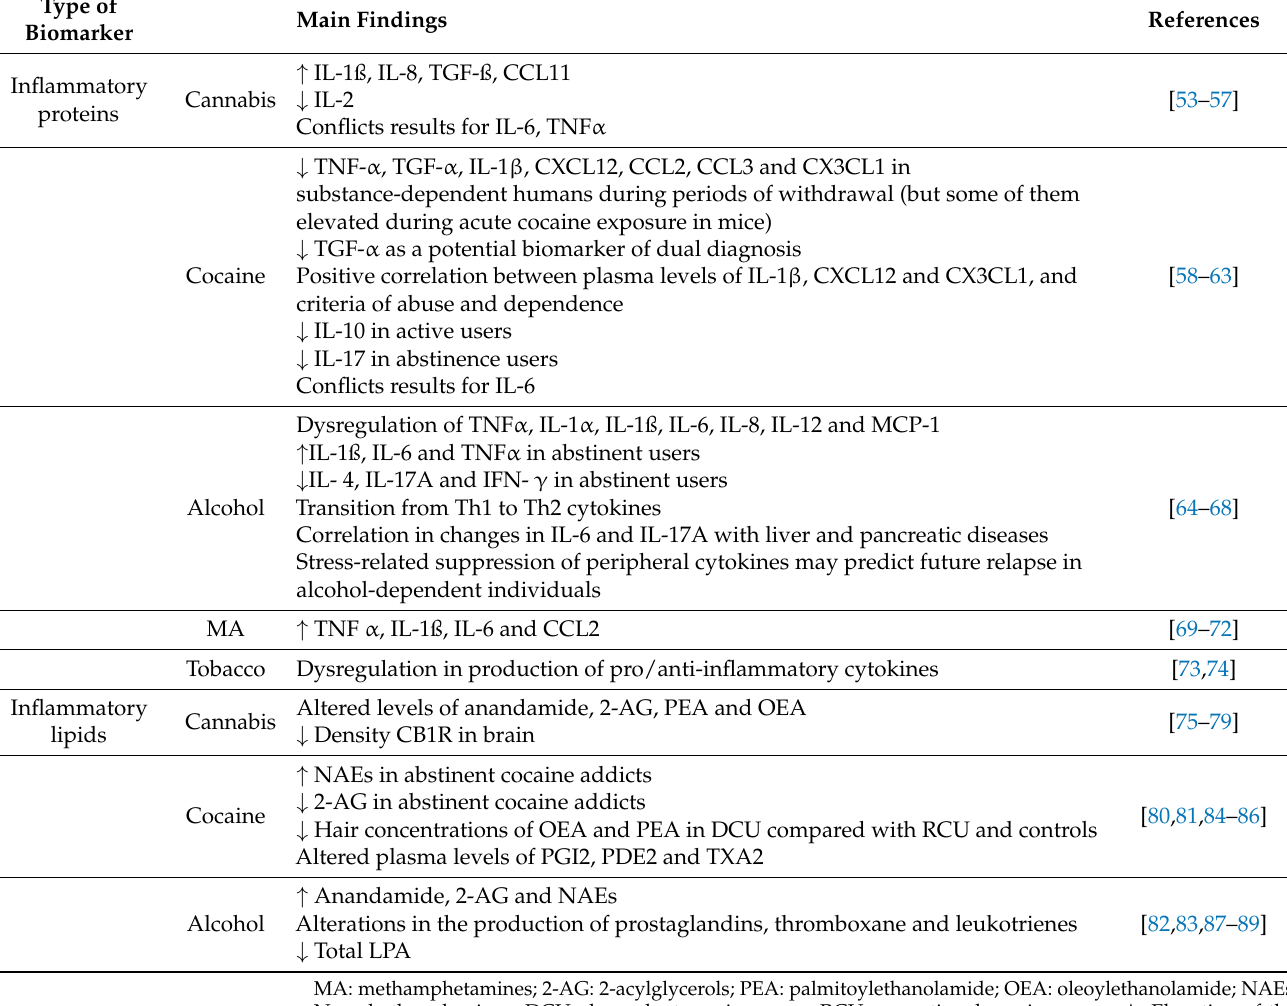
Table 4. Immuno-inflammatory markers in substance use